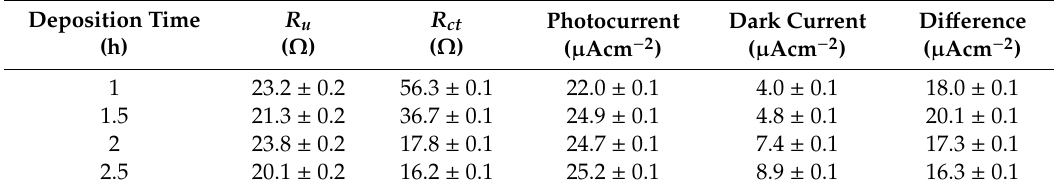
Table 2. Measured AC impedance data and photocurrent data of CdTe prepared at different deposition time.